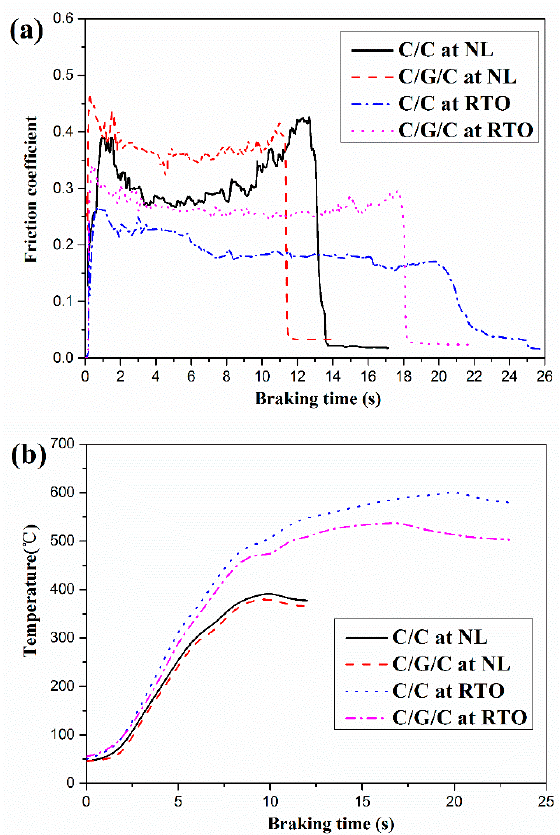
Figure 13. Typical braking curves of the C/C and C/G/C composites at the NL and RTO braking levels: ( a ) Friction coefficient of both composites; ( b ) The surface temperature of both composites.